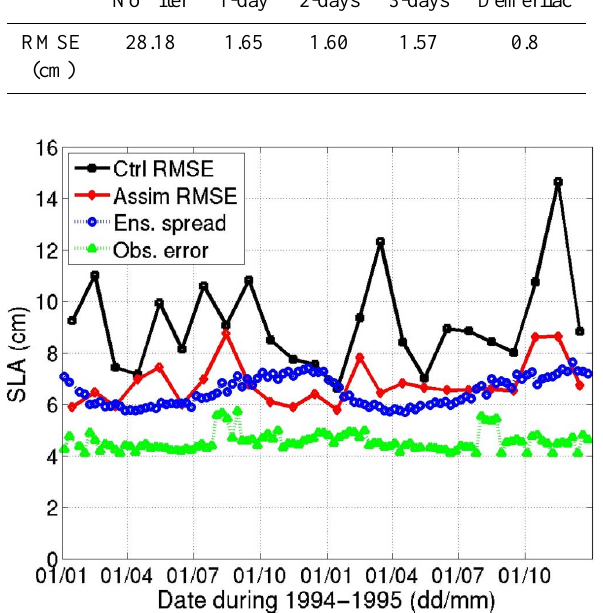
Fig. 8. Comparison of the monthly RMS error of SLA for the assimilation run ( Assim, red line) and the control run ( Ctrl , black line) during 1994-1995. The blue circle represents the “running” seasonal ensemble spread, and the green triangles represent the standard deviation of the observation error.